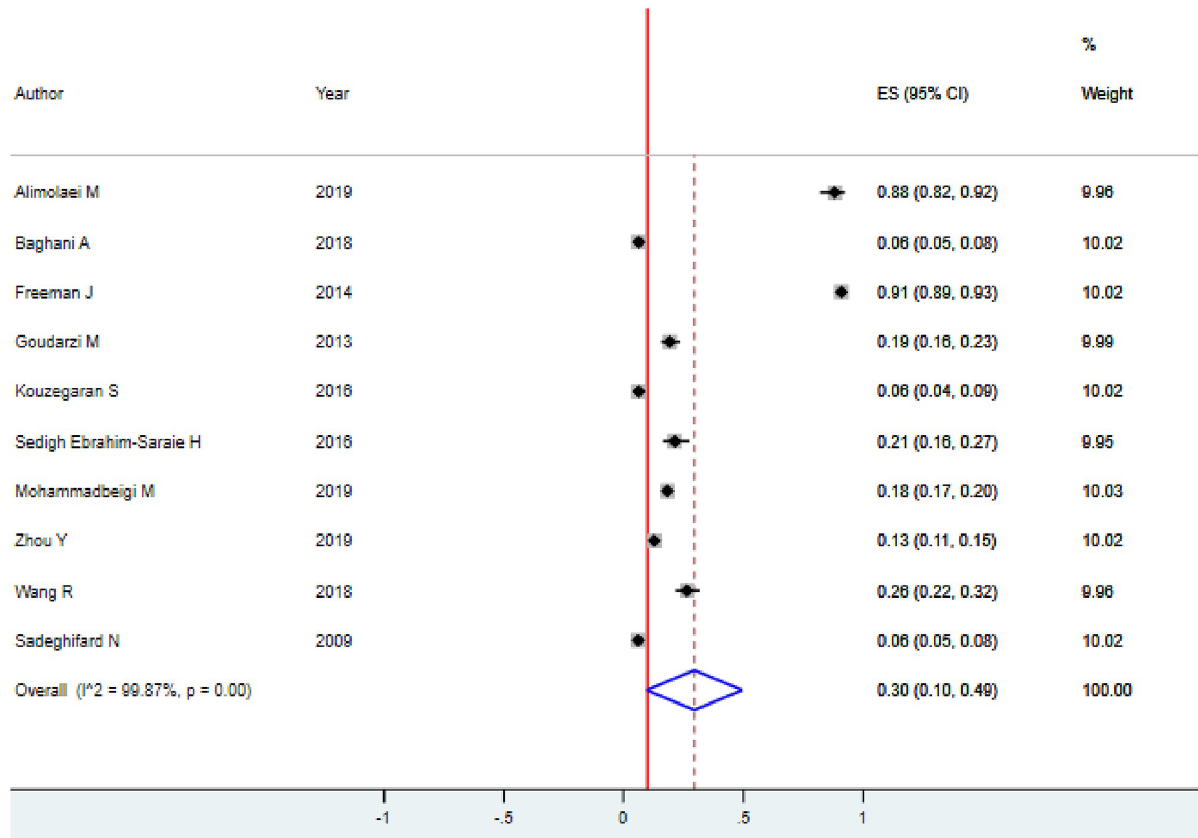
Fig 2. Forest plot for the proportion of C . difficile among hospitalized diarrheal